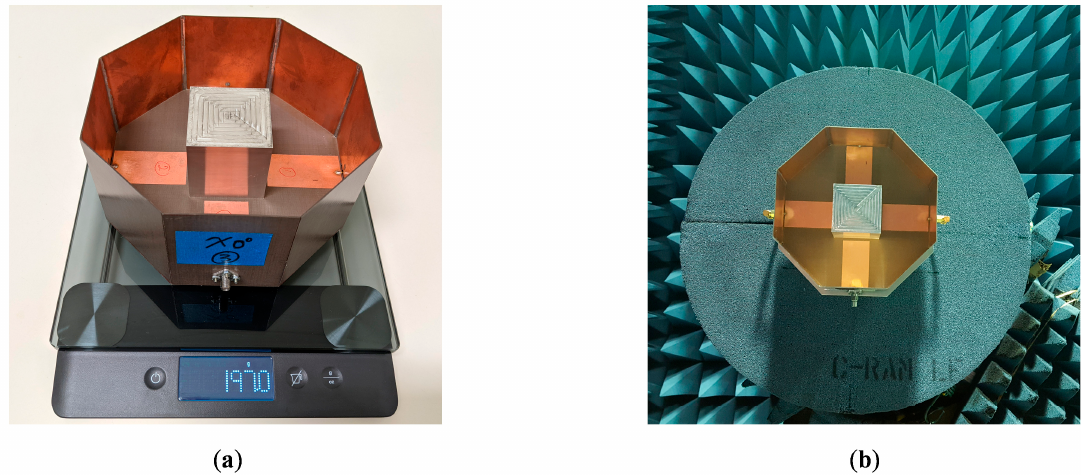
Figure 9. OCROP prototype: ( a ) Situated on mass scale; ( b ) In the test chamber for radiation patterns.